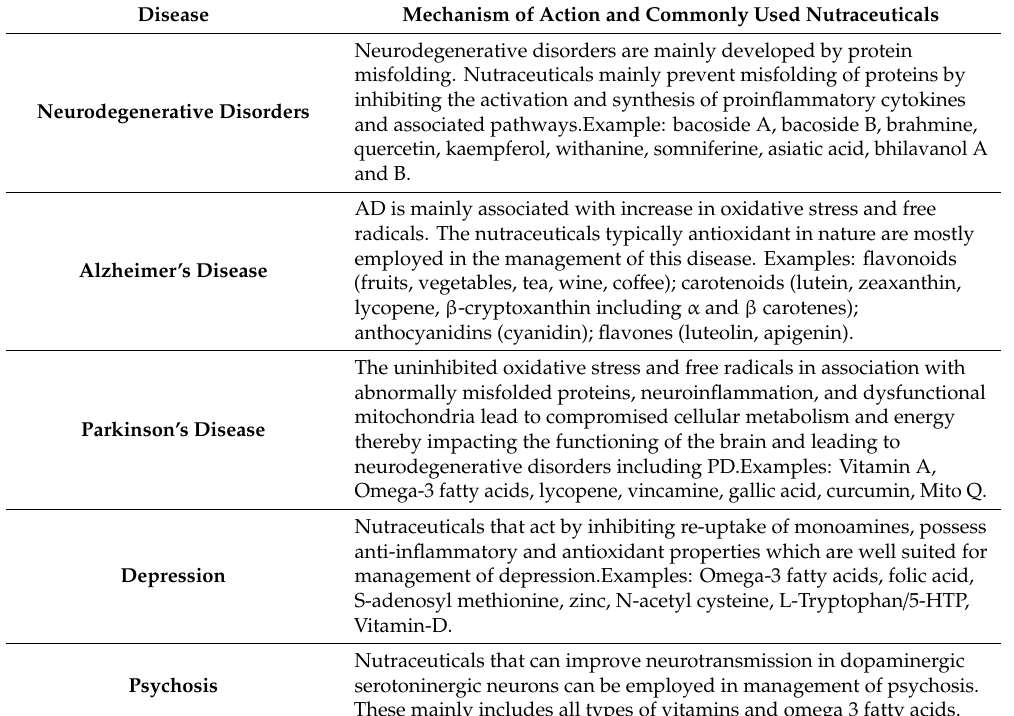
Table 2. Summary of the nutraceuticals discussed in the current review with their mode of action and specific disease activity